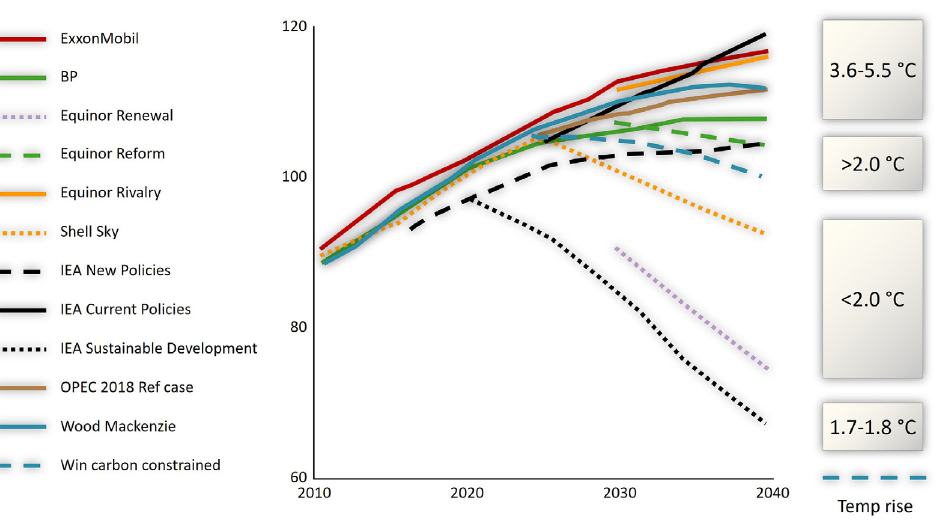
Fig. 14. – Global oil demand predictions in millions of barrels per day, 2010–2040 and the associated projected rise in global average temperature by 2100 (Source: Wood Mackenzie, April